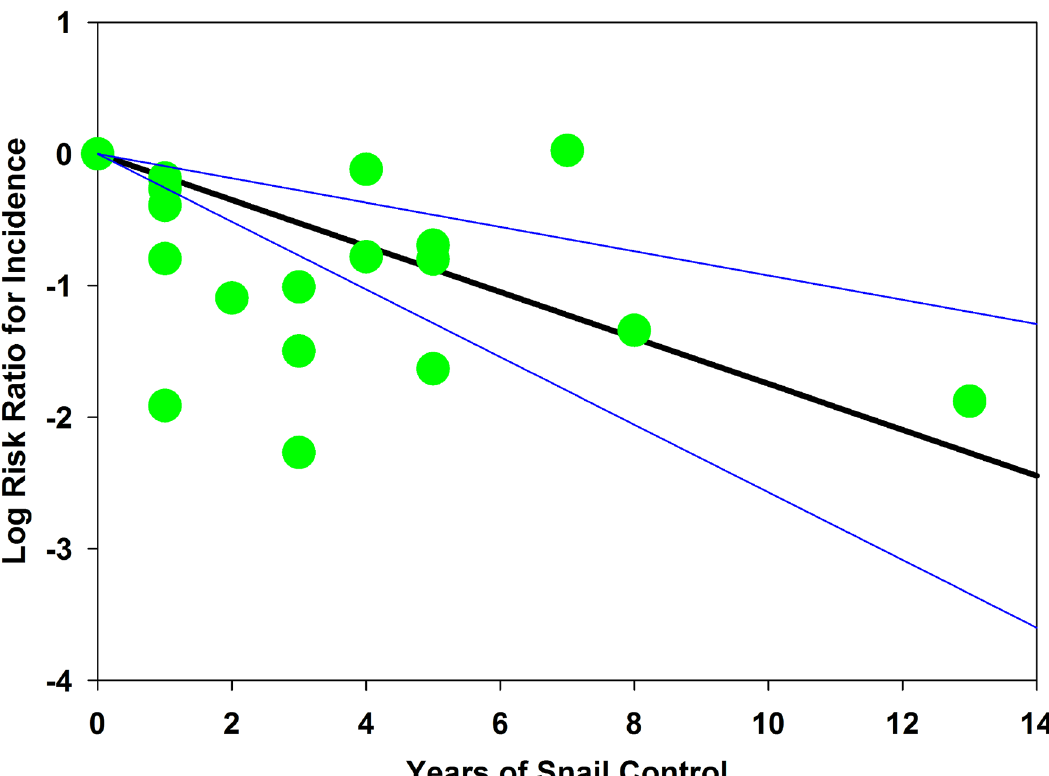
Fig 8. Meta-regression of Schistosoma infection incidence log-risk ratio according to the duration of mollusciciding control. Green circles indicate the point estimates for individual studies, graphed as the log risk ratio of infection after mollusciciding (y axis) against the reported duration of snail control (x axis). The dark line indicates the best-fit linear regression line for the combined studies, anchored at zero effect at time 0. The thin lines indicate the 95% confidence band for the regression.